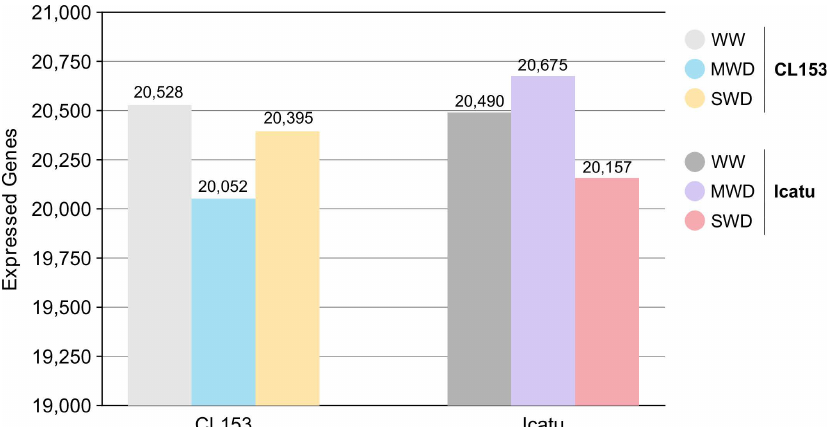
Figure 1. The total number of expressed genes Coffea arabica cv. Icatu (Icatu) and C. canephora cv. Conilon Clone CL153 (CL153) plants submitted to three different water availability conditions: well-watered (WW), moderate water deficit (MWD), and severe water deficit